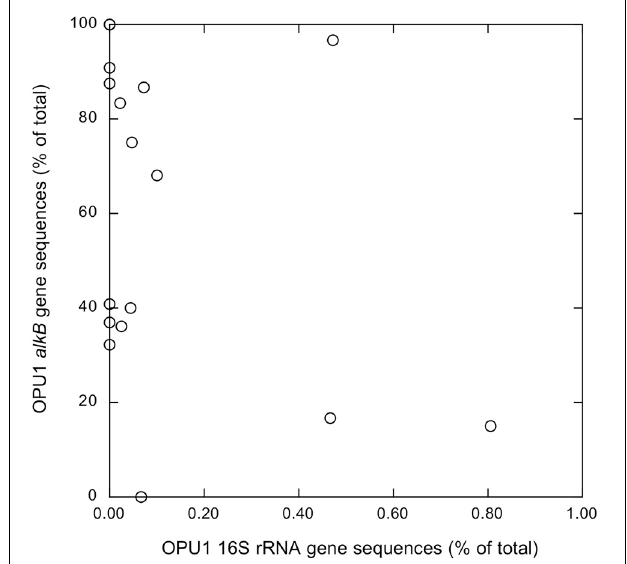
FIGURE 3 | Alcanivorax -like alkB gene sequence relative abundances of as a function of Alcanivorax 16S rRNA gene sequence relative abundances; alkB results from this study, 16S rRNA results taken from King et al.